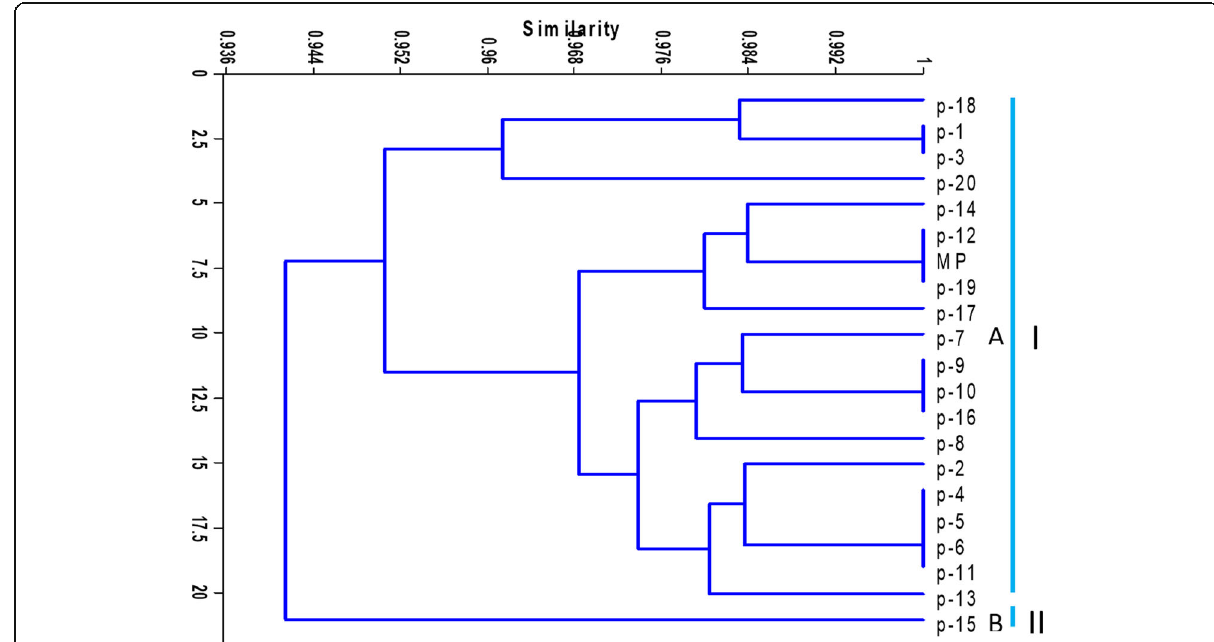
Fig. 3 Dendrogram showing the micropropagated plants and mother plants. Based on Genetic distance Method UPGMA (Jaccard